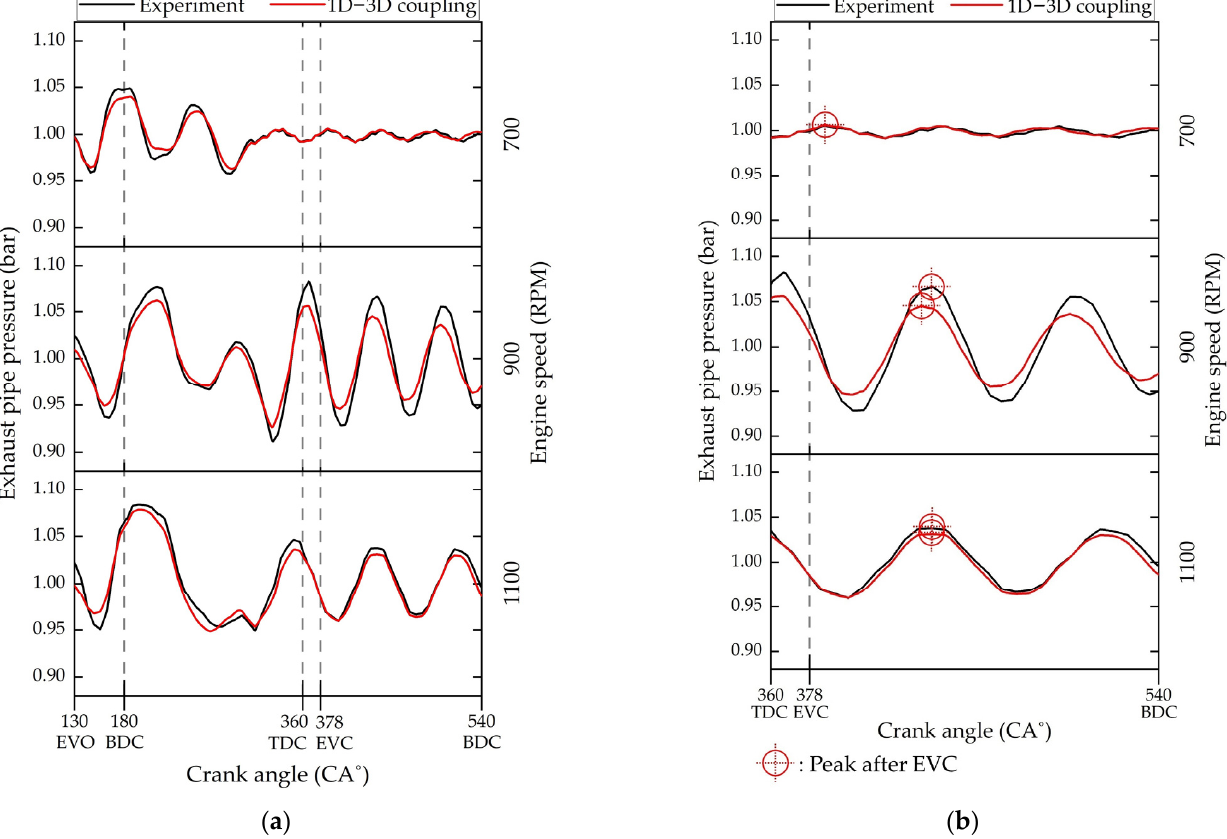
Figure 5. Exhaust pipe pressure results during the exhaust process: ( a ) From exhaust valve opened to bottom dead center 540 CA°; ( b ) from top dead center 360 CA° to bottom dead center 540 CA°. Table 4. Maximum pressure results of the exhaust pipe after BDC according to the engine speed.